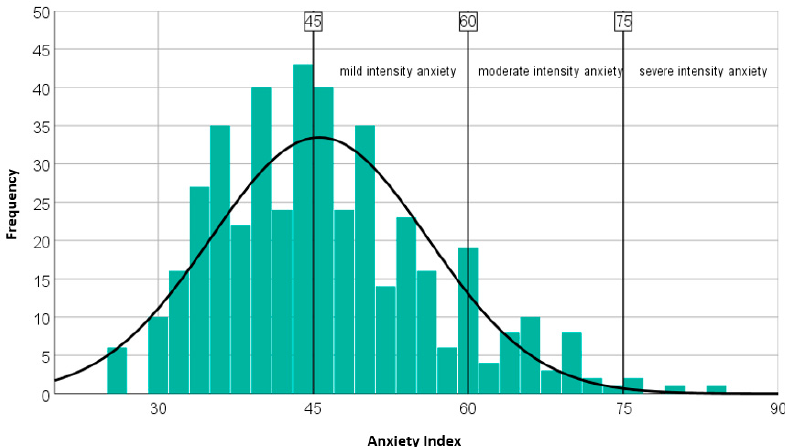
Figure 4. Level of anxiety on the SAS. In total, 49.3% of the respondents (N = 217) reported high levels of anxiety: mild intensity 38.6% (N = 170), moderate intensity 9.9% (N = 43), severe intensity 0.8% (N = 4).